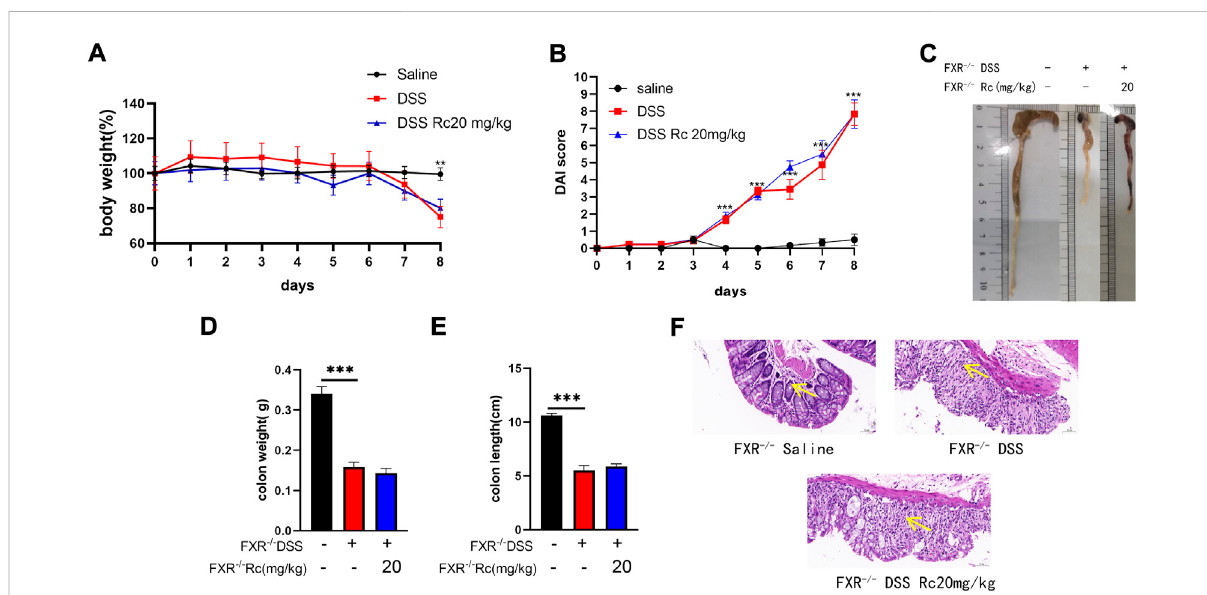
FIGURE 6 Rc did note ameliorated DSS-induced UC in FXR − /- mice. Body weight (A) changes and disease activity index (B) during the whole experiment; macroscopic observation of colon length (C) ; the statistics of colon weight (D) and colon length (E) representative H&E-stained colon sections (magni fi cation: 200 ×) (F) . Data are shown as the mean ± SEM ( n = 6). ** p < 0.01, *** p < 0.001 vs . the saline